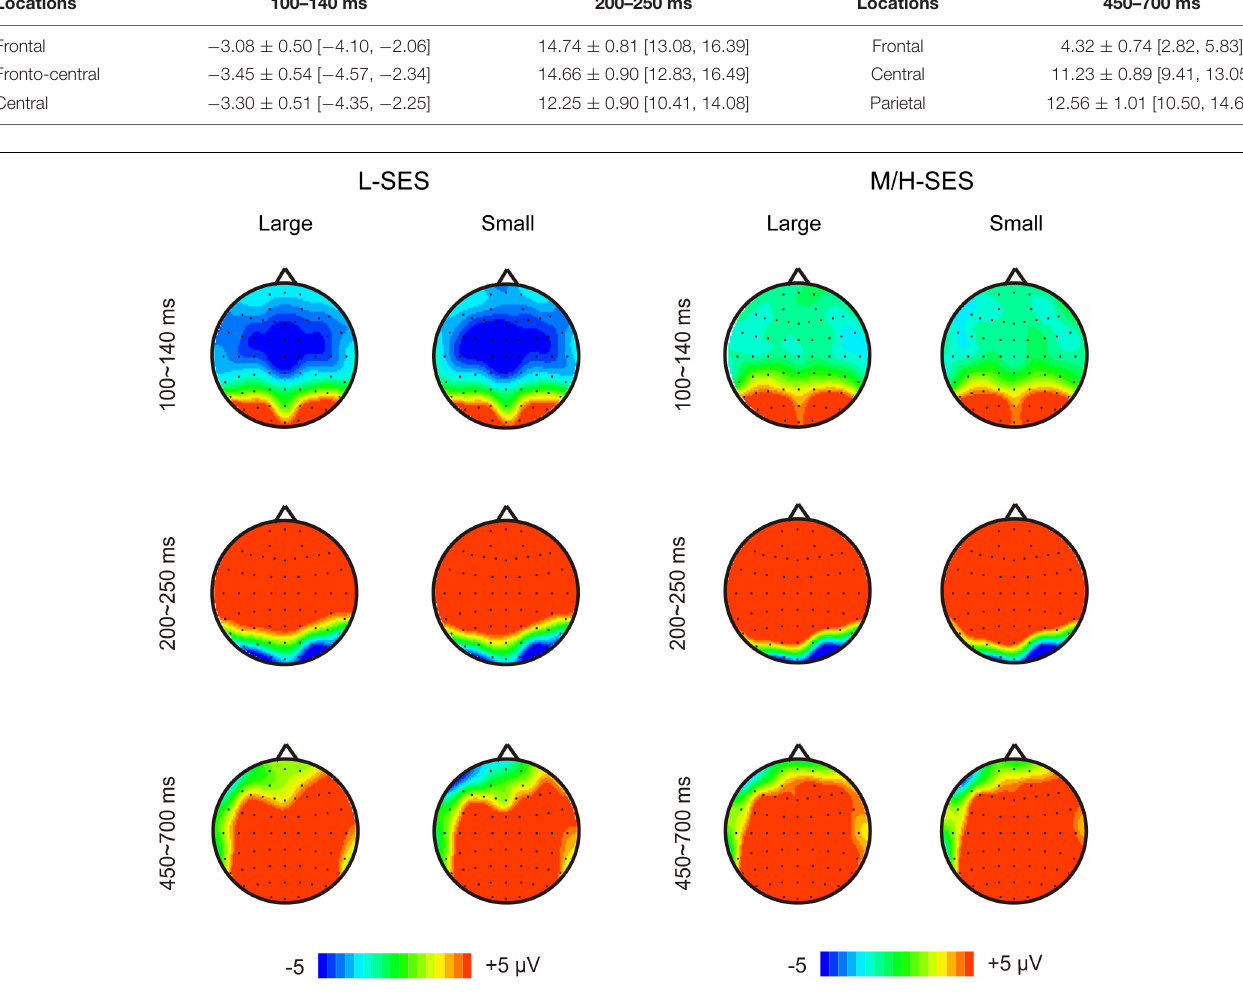
FIGURE 4 | The topographical maps for the children with different SES in different conditions. L-SES, low SES; M/H-SES, middle/high SES; Large, large distance; Small, small